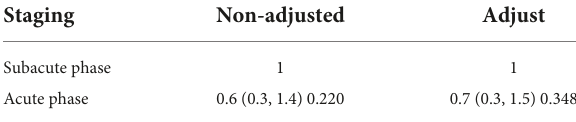
TABLE 3 Multivariate regression results of TEVAR in different